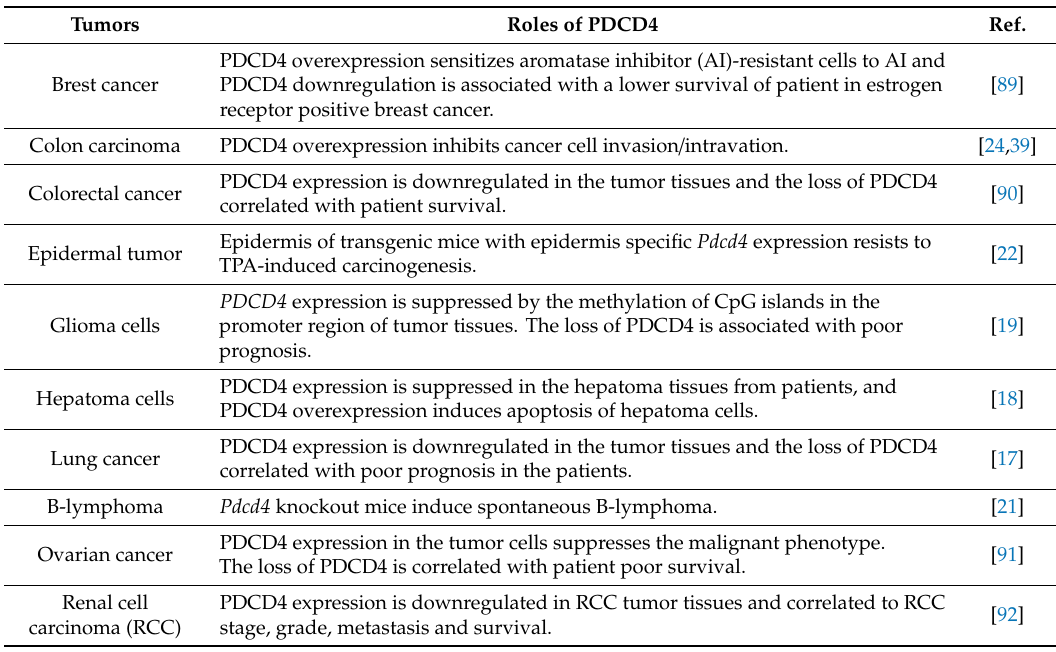
Table 2. Anti-tumor activity of